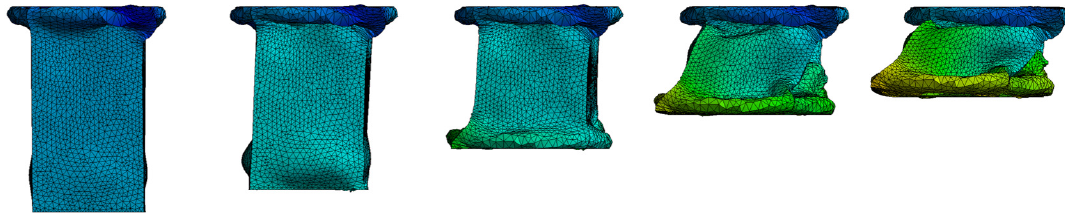
Figure 10. Load vs. displacement curves for novel cell under axial load: comparison between exper- imental and FEA. The experimental reaction force versus displacement curves of the novel cell geome- try under lateral loading are shown in Figure 11. The initial linear elastic response is fol- lowed by the plastic buckling of the vertical cell walls, as shown in Figure 12. Immediately after wall buckling, the cell mid-section fails by shear, which makes the reaction force continue to drop. This failure occurs as a result of the antisymmetric-buckling curvature of the vertical walls, combined with the stress concentration region within the cell ob- served in the FE model (see Figures 13 and 14). In this case, densification starts after ap- proximately 17 mm of displacement. The maximum shear stress at the mid-section of the novel cell obtained by FE analysis was 17.6 MPa. Figure 15 shows good agreement be- tween FE results and experiments. The averaged experimental absorbed energy and max- imum reaction force of the novel cell under lateral load were 27.0 J and 4.8 kN, respec- tively. The specific energy absorption corresponding to a crushing length of 14.8 mm was 0.19 J/g. The performance of the new cell design under quasi-static compression loading was compared to that of the conventional hexagonal cell. Experimental and FE results are summarized in Table 2. Figure 16 shows the experimental load versus displacement curves of the hexagonal cell under the axial compression test. In this case, the averaged absorbed energy and maximum reaction force were 164.7 J and 6.5 kN, respectively. The specific energy absorption corresponding to a crushing length of 42.3 mm was 1.17 J/g; this demonstrates that the novel cell design and the hexagonal cell have similar perfor- mance in the axial direction. Experimental deformation behavior was replicated with very good agreement by the FE model, as shown in Figures 17 and 18. In Figure 19, experi- mental load versus displacement curve is compared with FE results, showing excellent agreement. In the lateral direction, the hexagonal cell showed an averaged energy absorp- tion of 23.5 J and a maximum reaction force of 2.0 kN. The specific energy absorption, corresponding to a crushing length of 17.5 mm, was 0.16 J/g. Compression test results of